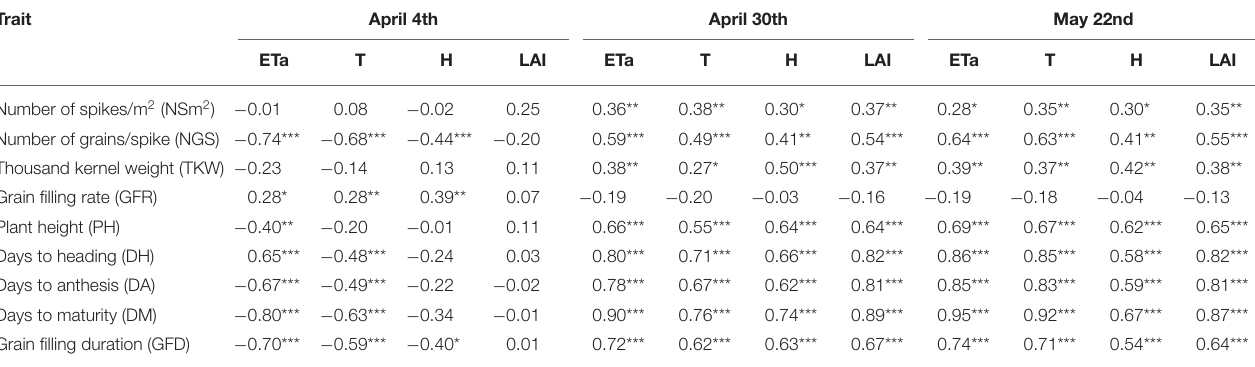
TABLE 4 | Pearson correlation coefficients ( r ) for the relationships between traits assessed through remote sensing and agronomic traits other than yield for each image acquisition event across irrigation treatments ( n =